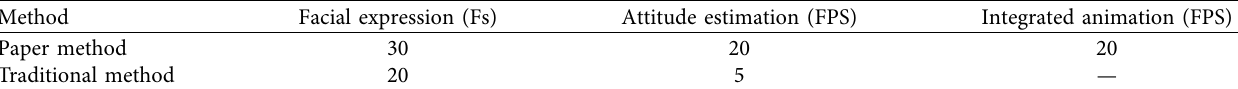
Figure 8: ORPM network Table 3: Animation frame rate generated by different methods.